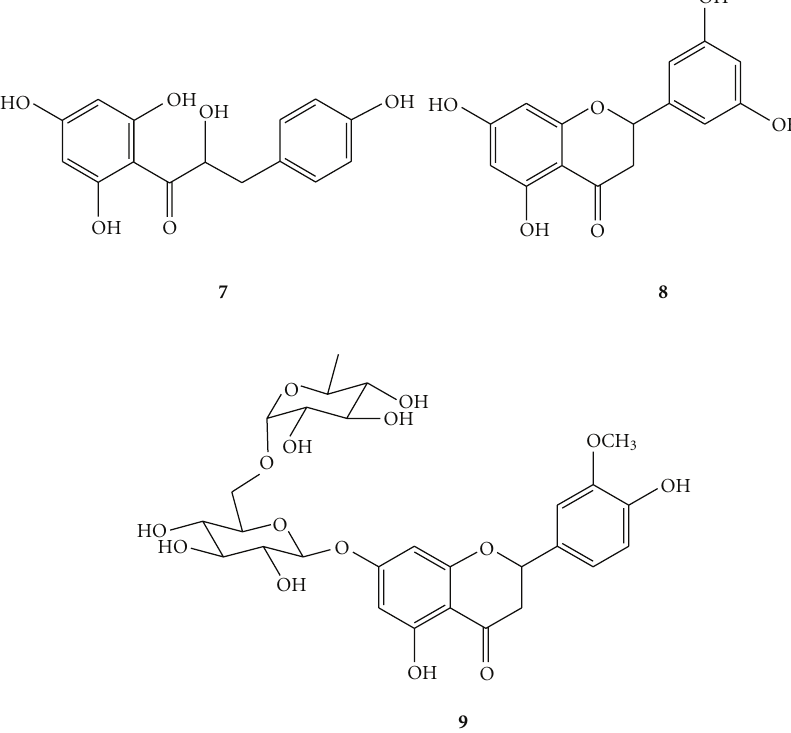
Figure 1: Chemical structures of the isolated dihydrochalcone and flavanones from Satureja spicigera .